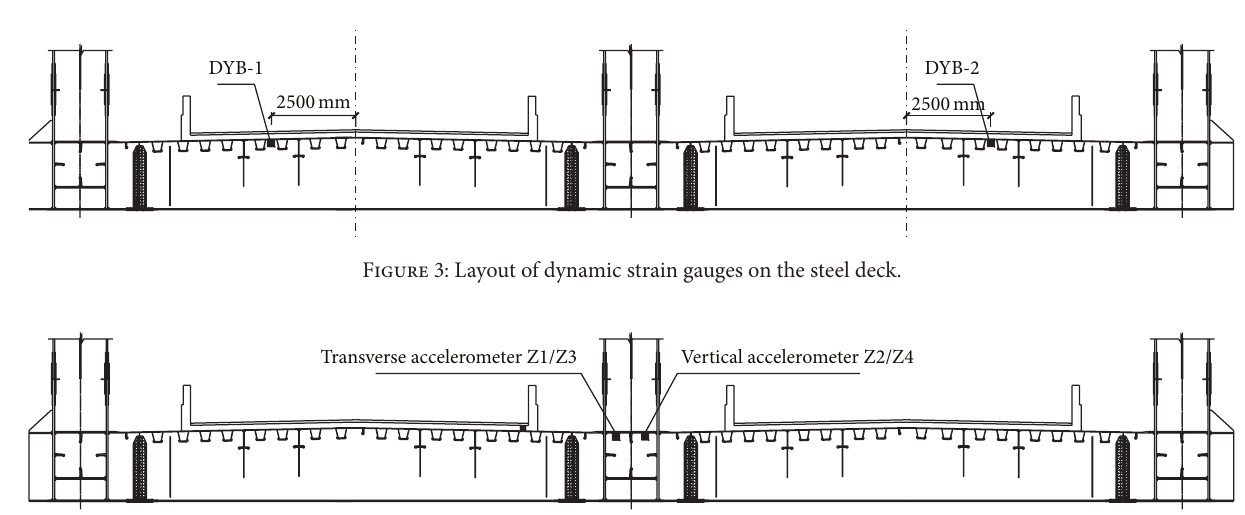
Figure 4: Layout of accelerometers on the steel